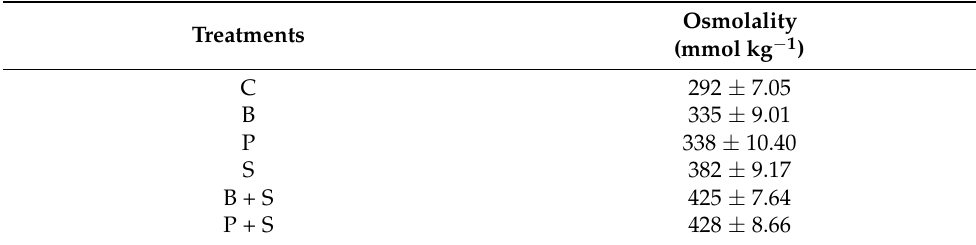
Table 1. Effect of BABA and PEG seed priming on osmolality in cowpea seedlings exposed to PEG stress. C (control), B (BABA-primed seedlings without any stress), P (PEG-primed seedlings without any stress), S (unprimed seedlings subjected to PEG stress), B + S (BABA-primed seedlings subjected to PEG stress), P + S (PEG-primed seedlings subjected to PEG stress). Values represent the mean ± SE of three independent experiments. Alphabetical letters show significant difference between treatments performed using Duncan’s multiple range